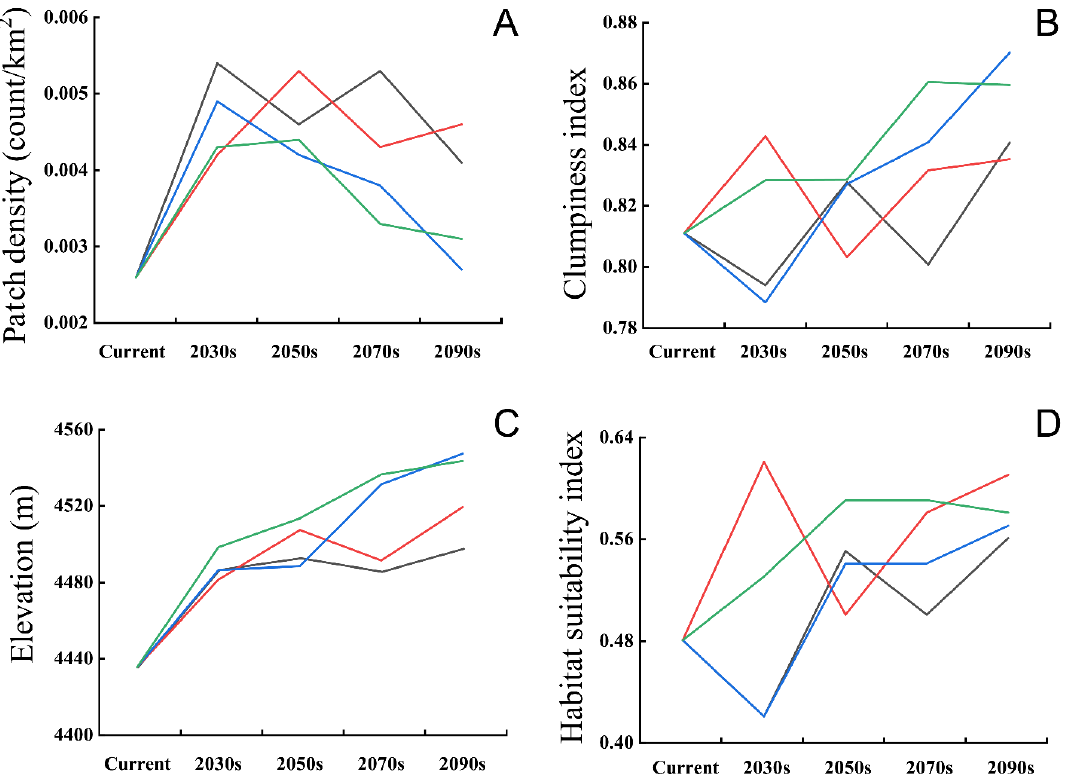
Figure 5. Effects of climate change on patch density ( A ), Clumpiness index ( B ), mean elevation ( C ), and mean habitat suitability index ( D ) of the black-necked crane distribution range, under shared socio-economic pathway SSP1-2.6 (black lines), SSP2-4.5 (red lines), SSP3-7.0 (blue lines) and SSP5-8.5 (green lines).